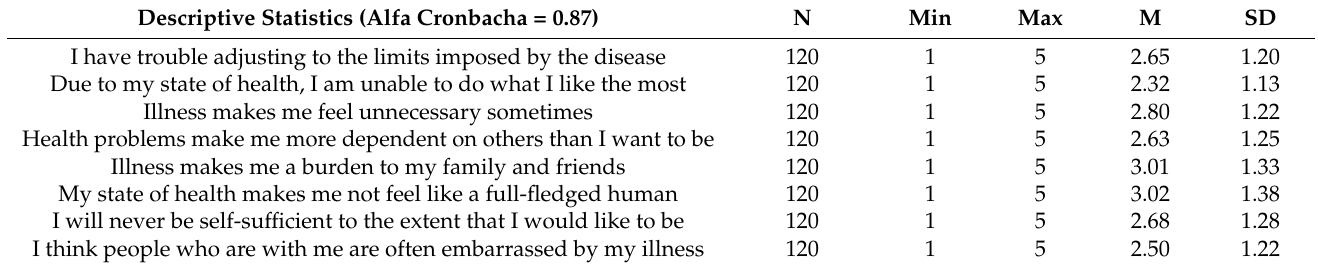
Table 5. Acceptance of the illness according to the AIS questionnaire.